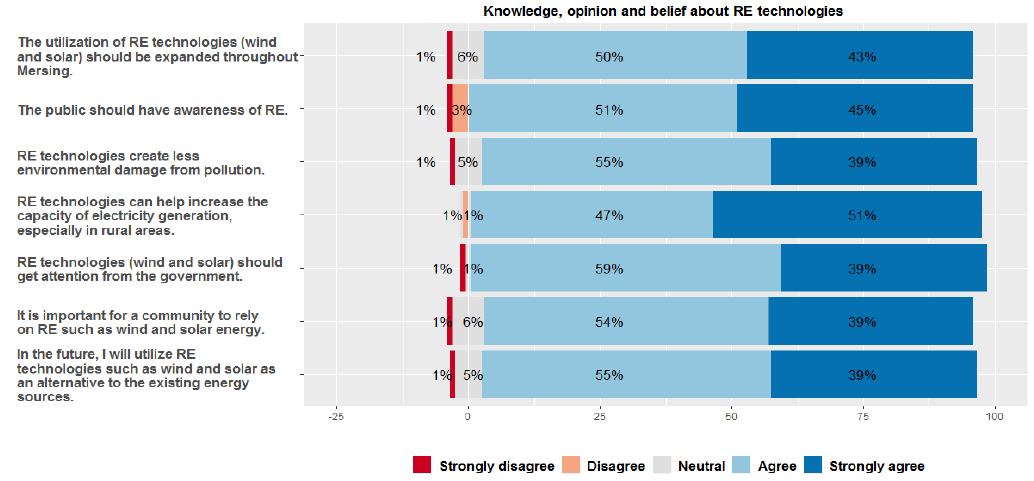
Figure 15. Respondents’ knowledge and opinions of and beliefs about RE technologies.